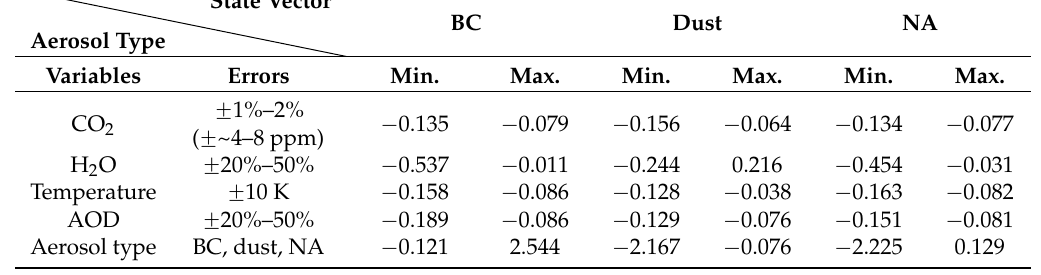
Table 5. Range of XCO 2 retrieval errors with respect to state vectors for BC, dust and NA aerosols for a SZA of 30° with respect to state. Units are in ppm.